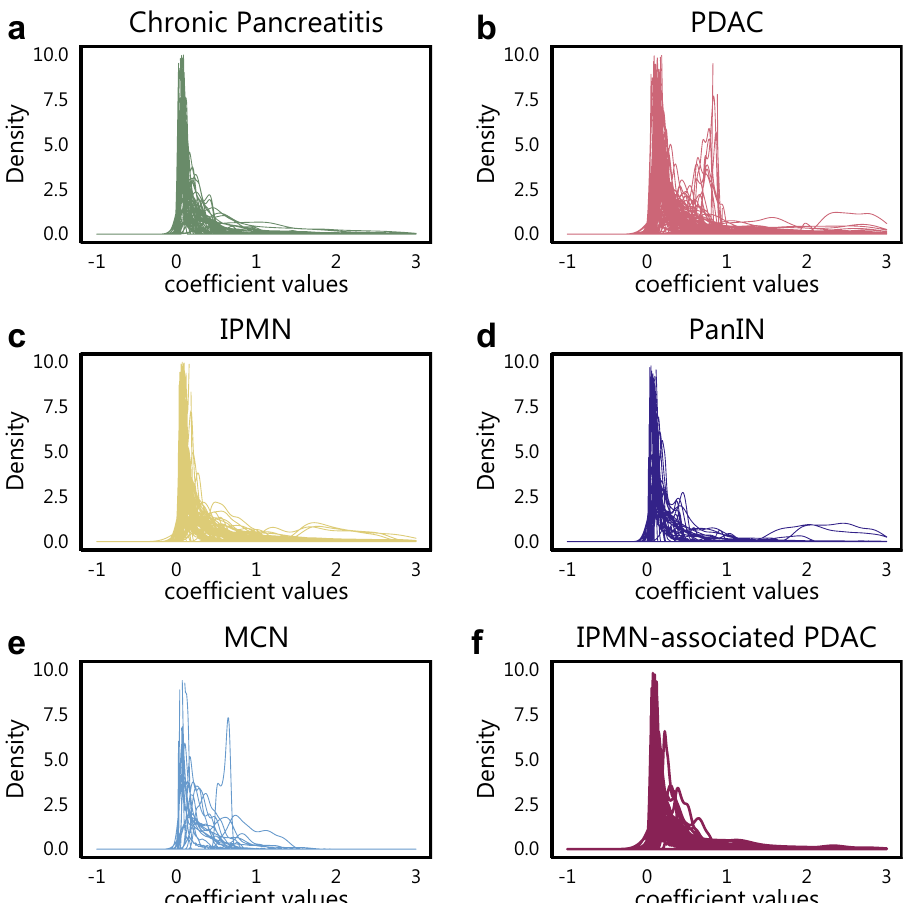
Figure 2. The density estimates for all subjects across all six pancreatic disease subtypes. Similar plots without truncation of the x- and y-axis are shown in Supplementary Fig. S3(online). Here, the x-axis corresponds to the GWR coefficient values obtained at every point on our GWR computation